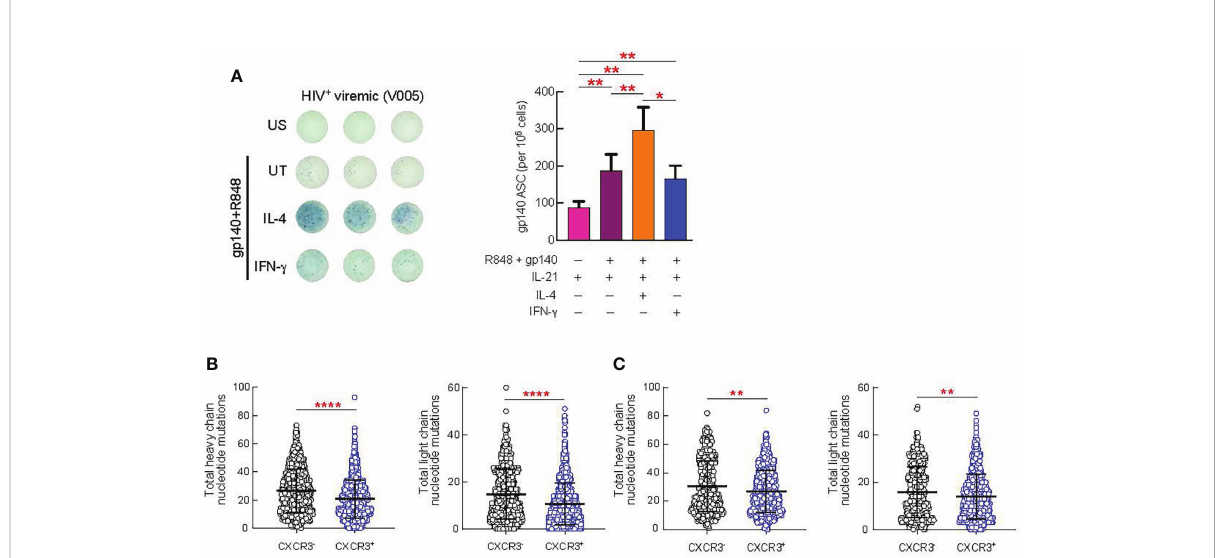
FIGURE 6 Effect of in vitro cytokine stimulation of B cells on antibody production and SHM. Lymph node (LN) mononuclear cells from 9 HIV + viremic individuals were stimulated or not for 4 days presence of gp140 (0.1 ug/ml) and R848 and in prensence or absence of IL-4 (100 ng/ml) and IFN- g (100 ng/ml). (A) Frequencies of gp140-speci fi c antibody secreting cells (ASC) were measured by ELISPOT. The left panel shows representative counting of spot-forming cells (SFC) and the right panel shows the frequency of gp140 ASC calculated from triplicate wells plated with 100.000 LNMCs per well. Total somatic mutations per antibody were determined by paired chain sequencing of CXCR3 + and CXCR3 - IgG B cells (B) or CXCR3 + and CXCR3 - gp140-speci fi c B cells (C) from fi ve donors. Error bars correspond to mean ± SEM and statistical signi fi cance was evaluated using Wilcoxon signed-rank test and in (D, E) by Mann-Whitney test. P values * P < 0.05, ** P < 0.01, **** P <